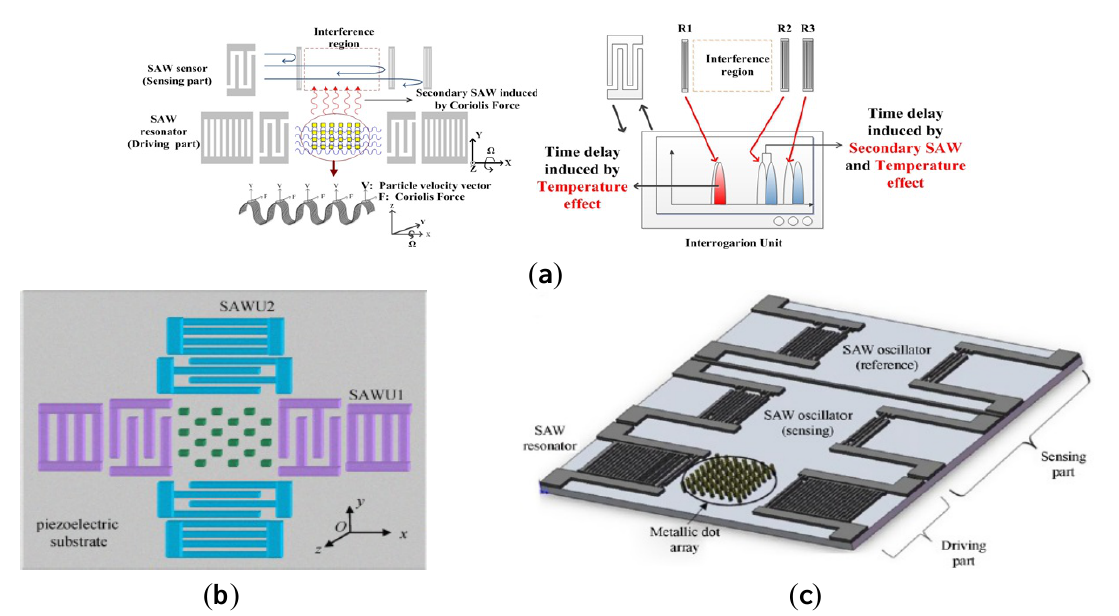
Figure 12. SAW gyroscopes. ( a ) A new kind of single axis SAW gyroscope. ( b ) A novel MEMS IDT dual-axes SAW